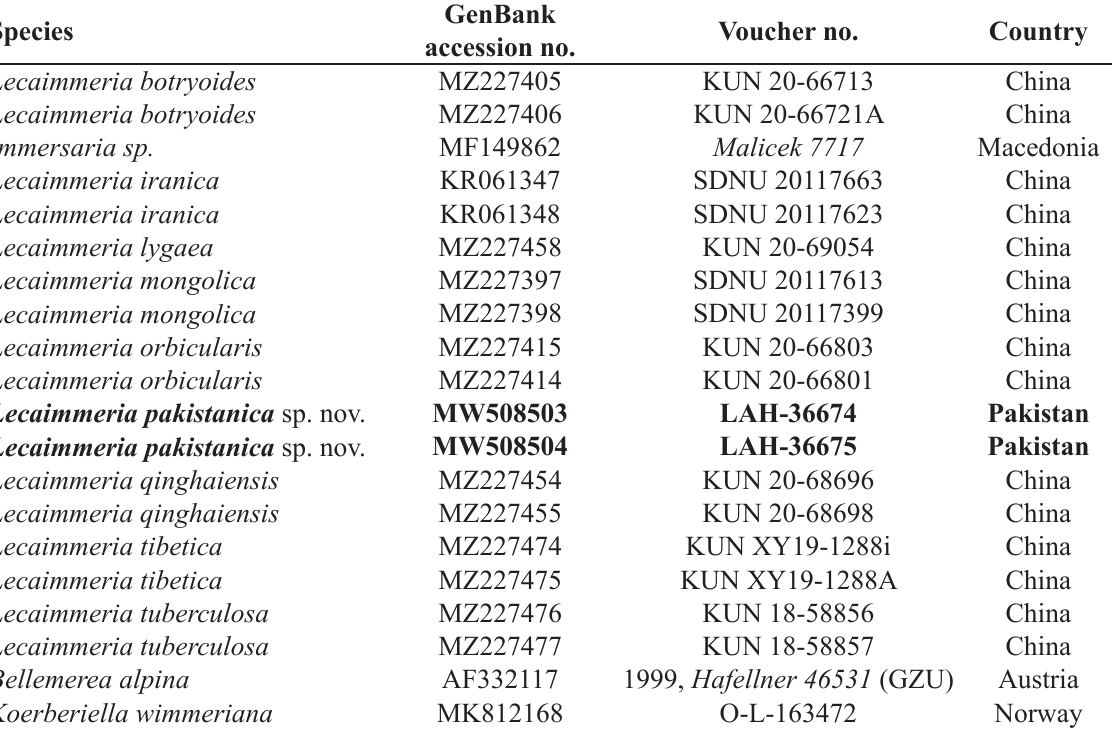
Table 1. Species used in the phylogenetic analysis. Pakistani collections are marked in